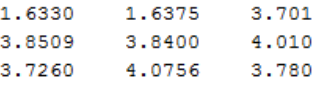
Figure 2. BCFM matrix.